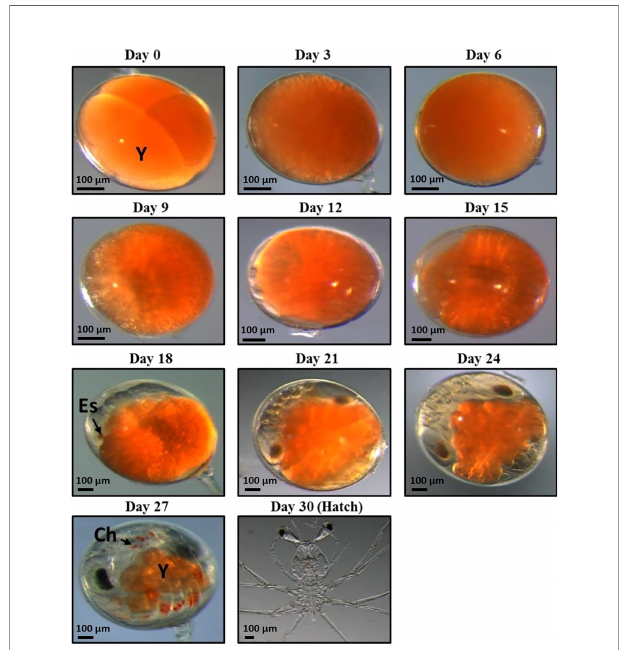
FIGURE 1 | 11 stages of Panulirus ornatus embryo development samples were taken for RNA extraction. Embryos were sampled every 3 days from day zero until hatch at day 30 (photos taken by Larnie Linton). Day 30 (hatch) photo is stage I phyllosoma, rather than hatched naupliosoma, which were unable to be photographed. There are 11 stages of embryonic development of P. ornatus ; fertilized egg, cleavage, blastula, gastrula, egg- nauplius, embryo with 7 appendage pairs, embryo with 9 appendage pairs, embryo with 11 appendage pairs, compound eye pigments, pre-hatching and hatching (Liang and He, 2012) Abbreviations are as follows: Y, yolk; Es, eye spot; Ch,